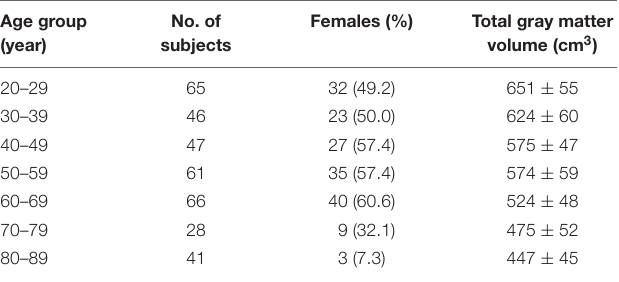
TABLE 1 | Normal aging cohort